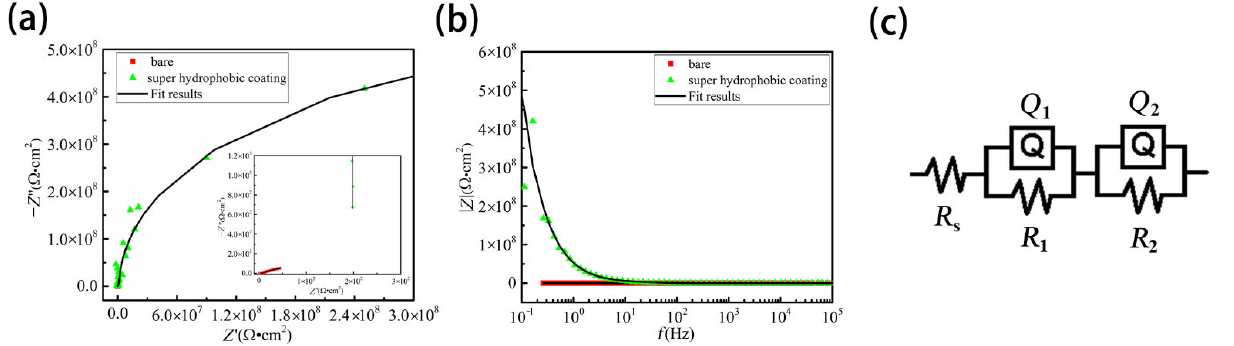
Figure 5. Electrochemical impedance spectroscopy (EIS) and equivalent circuit diagram of polished copper foil and coated copper foil in 3.5 wt.% Nacl solution. ( a ) Nyquist ( b ) Bode ( c ) equivalent circuit diagram. Table 2. Values corresponding to equivalent circuit diagram components.